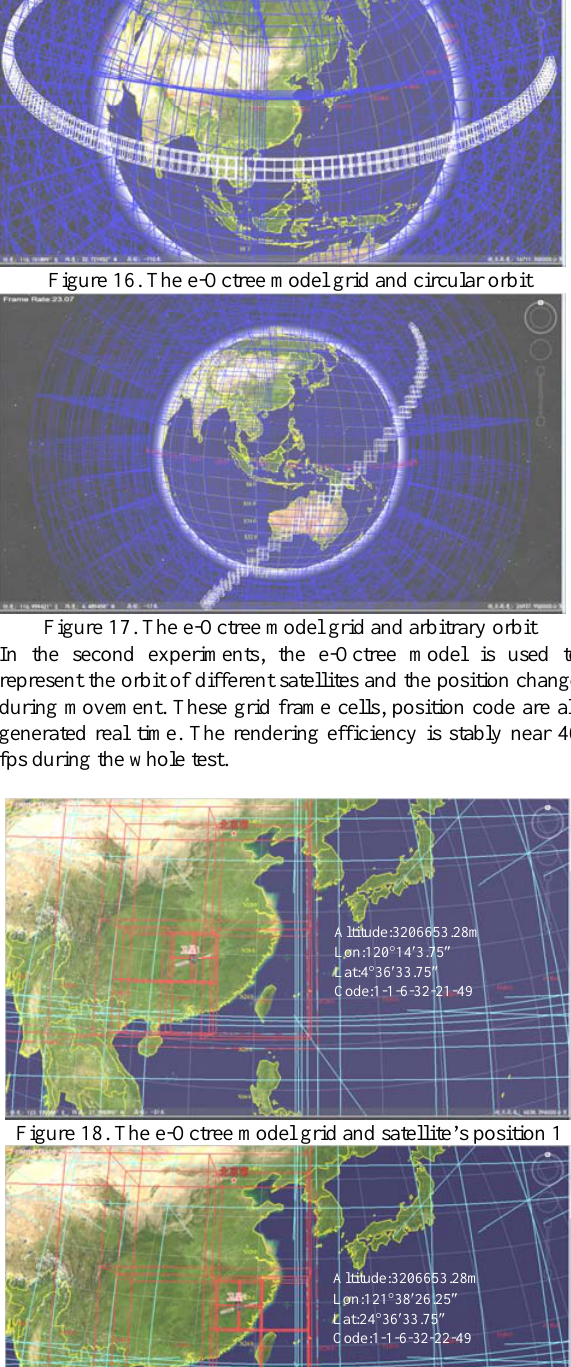
Figure 14. The e-Octree model grid and global terrain